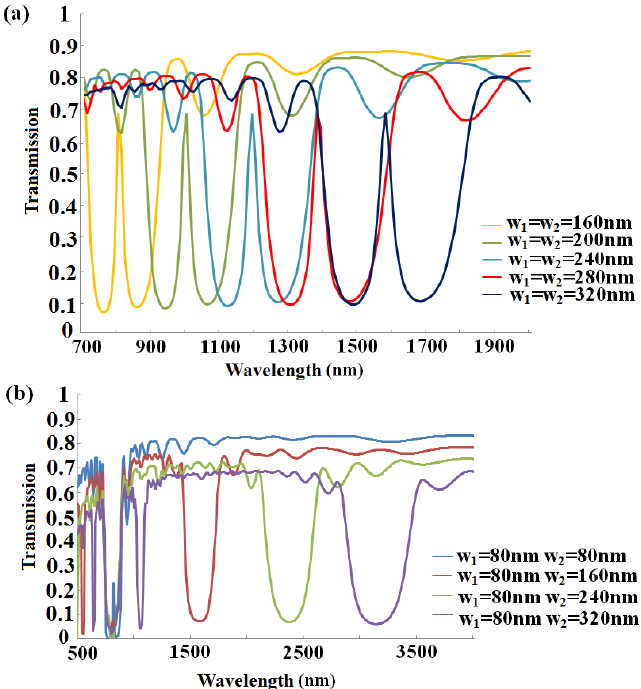
Figure 7. ( a ) The transmission spectra with grating width w 1 and w 2 increase together; ( b ) the transmission spectra with grating width w 2 changing and w 1 = 80 nm being fixed.